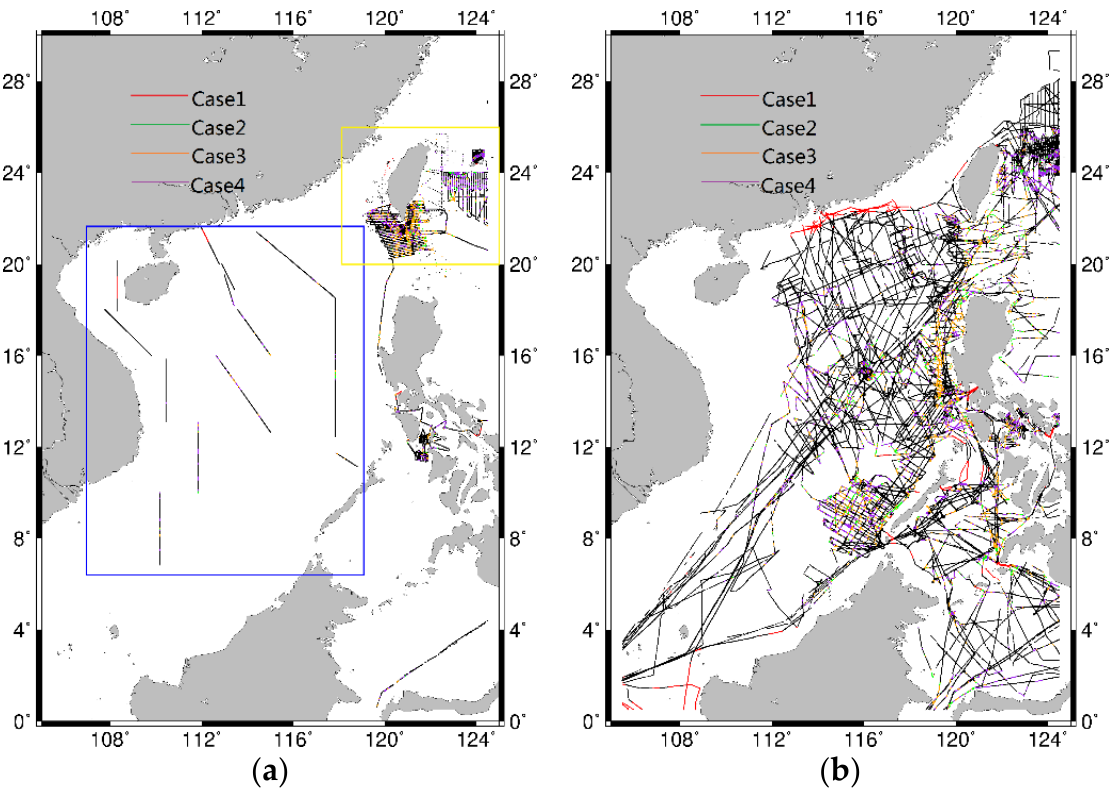
Figure 1. Shipborne gravity data tracks. ( a ) Shipborne data measured since 1990, ( b ) shipborne data measured before 1990. The tracks in the blue box are from Ministry of Natural Resources of P. R. China (MNR). The data in black are not in the refined area. The region in the yellow box is region A.